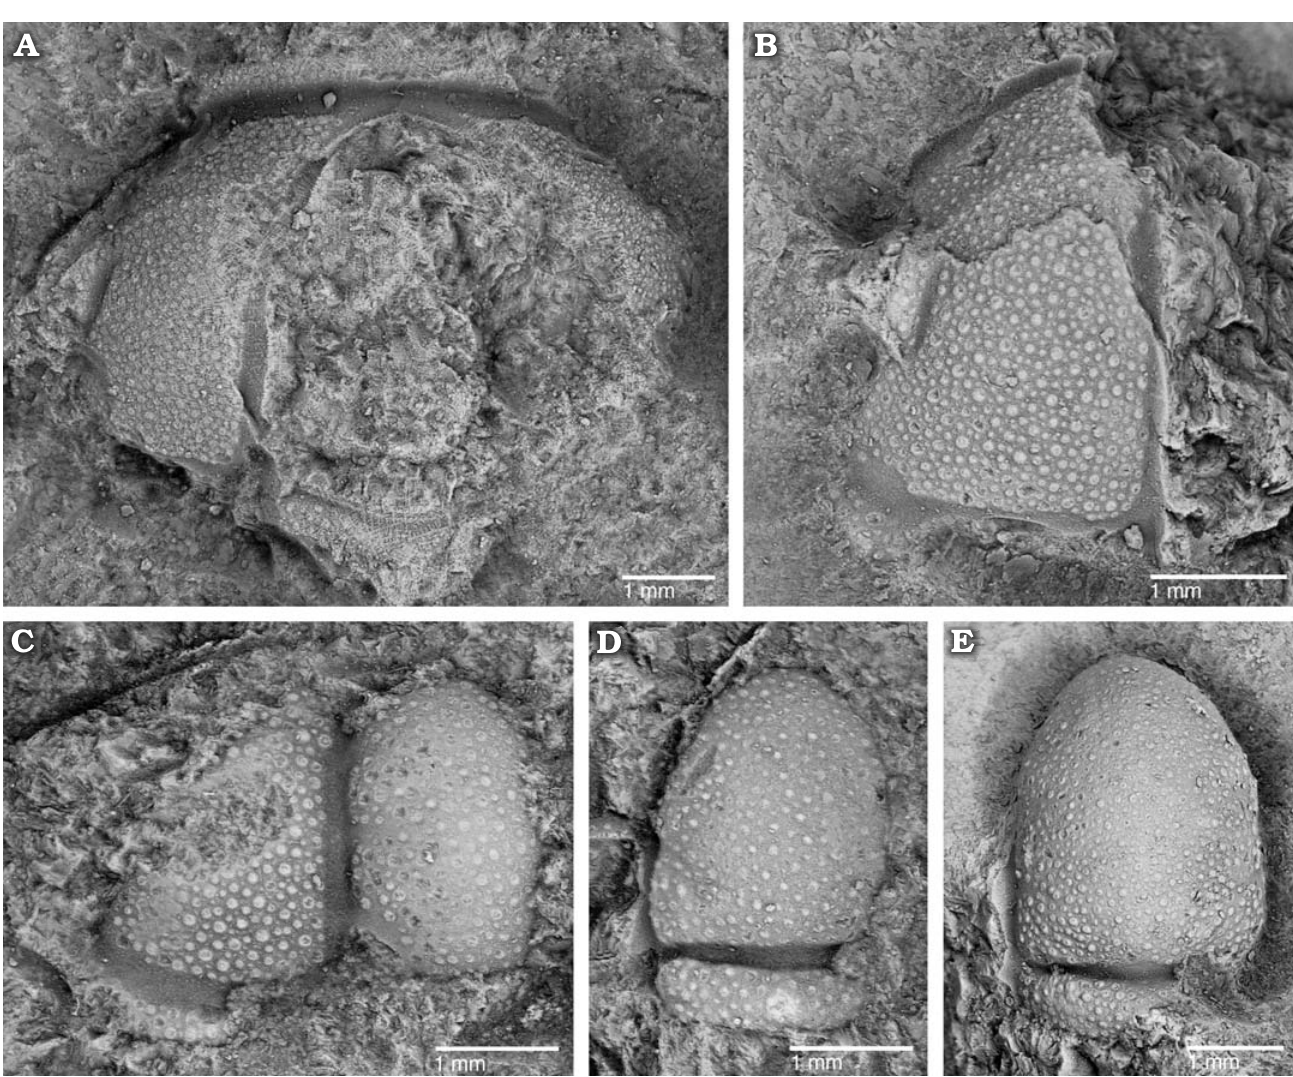
Fig. 4. The solenopleurid trilobite Trachoparia ? sp. from the lower Cambrian White Point Conglomerate, Kangaroo Island, South Australia. Partial testate cranidia in dorsal views. A . SAM P57222 showing short (sag., exsag.) anterior border. B . SAM P57223 showing faint eye ridge and palpebral lobe. C . SAM P57224 showing wide axial and posterior border furrows. D . SAM P57225 showing deep occipital furrow and subquadrate occipital ring. E . SAM P57226 showing strongly tapered glabella and subquadrate occipital